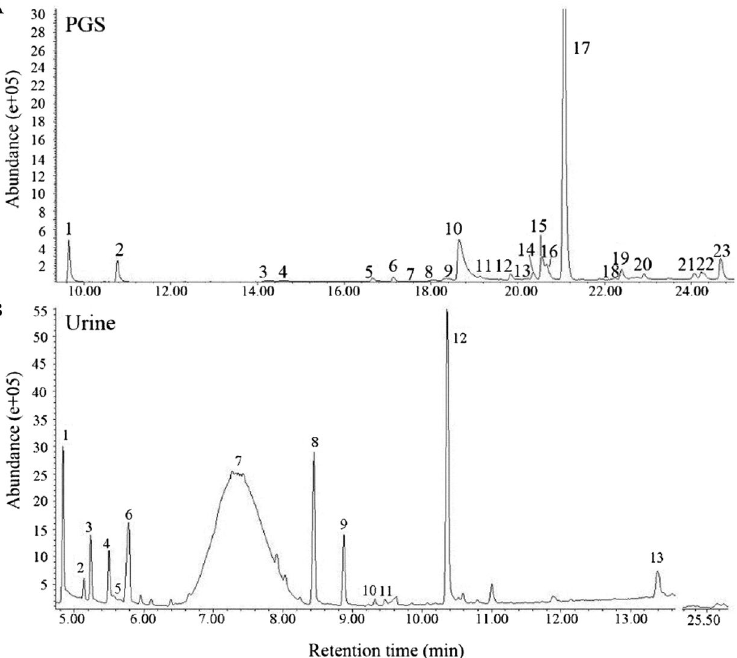
Figure 1. Representative gas chromatogram of PGS (top panel) and urine (bottom panel) from male mice. The numbers used to label GC peaks correspond to the peak numbers in Tables 1 and 2. PGS: preputial gland secretion.